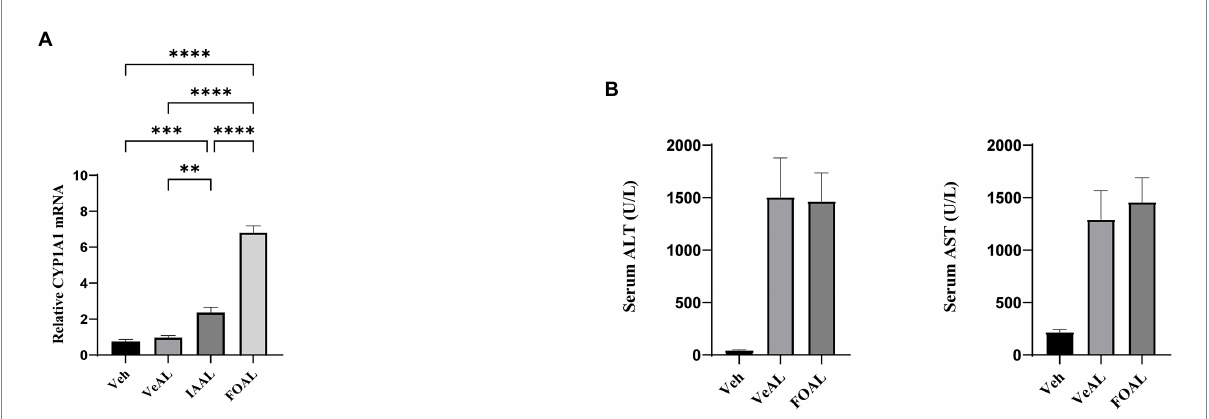
FIGURE 7 Oral gavage of IAA activated liver AHR signaling and the activation of AHR signaling had no impact on D-GalN/LPS induced-ALI. (A) Relative expression of CYP1A1 mRNA in liver. (B) Serum levels of ALT and AST. The data are presented as the mean ± SEM. ** p < 0.01; *** p < 0.001 and **** p < 0.0001 for the comparison. Veh, Vehicle (saline control); VeAL, Vehicle + D-GalN/LPS; IAAL, IAA + D-GalN/LPS; FiAL, Ficz+ D-GalN/LPS. n = 10 in each